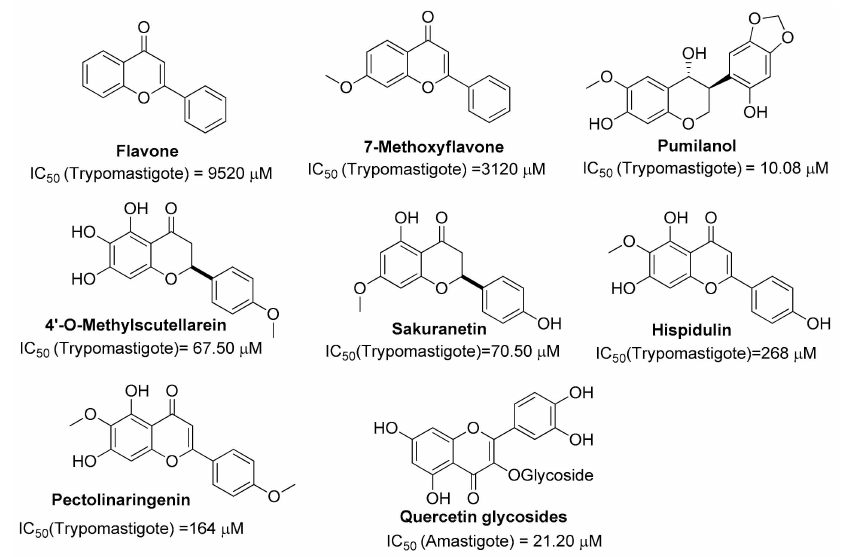
Figure 1. Structure of flavonoids with anti- Trypanosoma cruzi